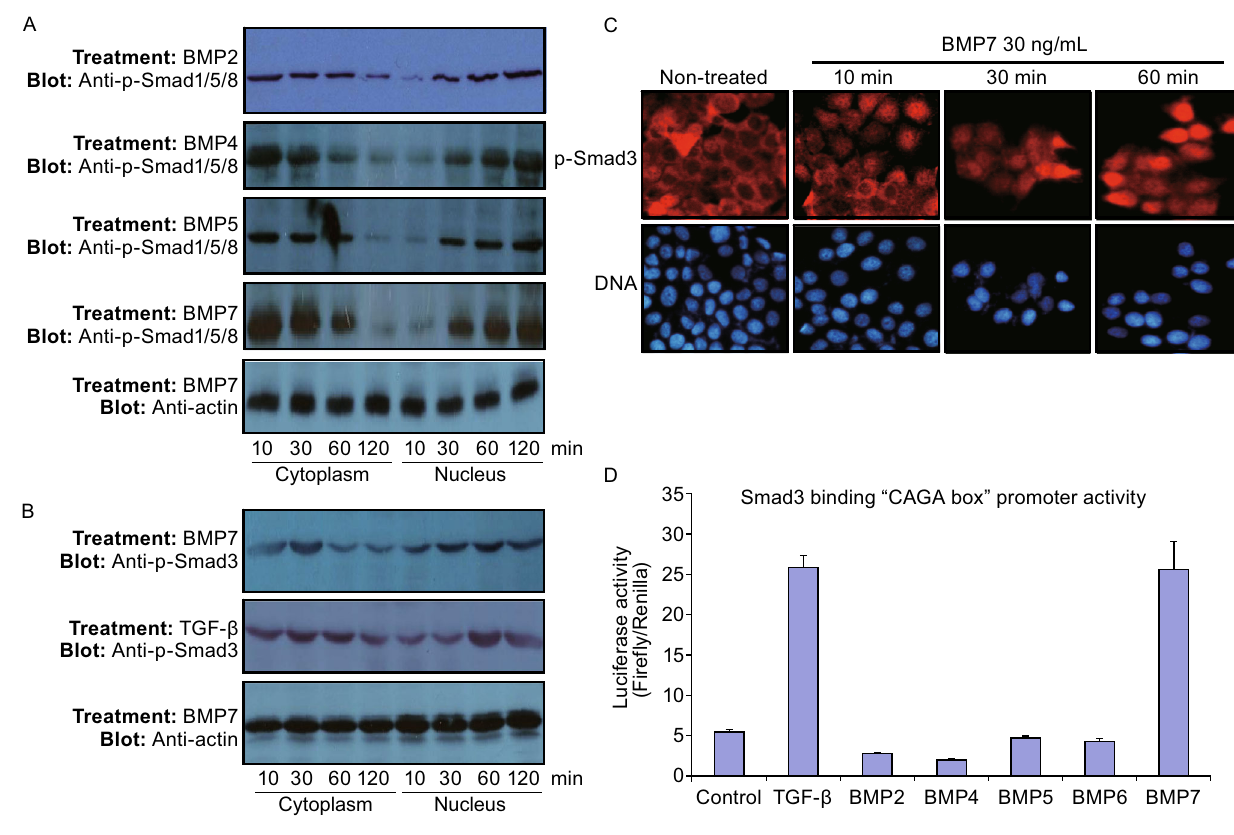
Figure 5. BMP7 induces Smad3 phosphorylation, nuclear translocation and gene transcriptional activity. (A) Smad1/5/8 phosphorylation and nuclear accumulation stimulated by BMP7, BMP2, BMP4 and BMP5. MCF-7 cells were incubated with the cytokines (30 ng/mL) for different time periods as indicated. Cells were fractionated by differential centrifugation for the cytoplasmic and nuclear fractions. Phosphorylation of Smad1/5/8 complex in response to the different cytokines as indicated was examined by Western blotting using speci fi c anti-phosphorylated Smad1/5/8 antibodies. (B) Smad3 phosphorylation and nuclear accumulation stimulated by BMP7 and TGF- β . MCF-7 cells were incubated with BMP7 or TGF- β (30 ng/mL) for 10, 30, 60 and 120 min. Cells were fractionated and Smad3 phosphorylation was determined Western blotting using speci fi c anti-phosphorylated Smad3 antibody. Protein loading controls in each fraction were monitored by Western blotting using anti-actin antibodies. Data were representatives of at least thee similar experiments. (C) Immuno fl uorescence staining of phosphor-Smad3 in BMP7-treated MCF-7 cells at different time points. Cells were treated with BMP7 for different periods of time as indicated. Micrographs of immuno fl uorescence staining using speci fi c antibody against phosphor-Smad3 and staining for the nuclei are shown. (D) BMP7 activation of Smad3 inducible (CAGA)12 Luc promoter. Cells transfected with pCAGA12 Luc were treated with different cytokines as indicated at the concentrations of 10 ng/ mL for 24 h. Luciferase activity was determined as described in MATERIALS AND METHODS. Data are mean ± SD from four